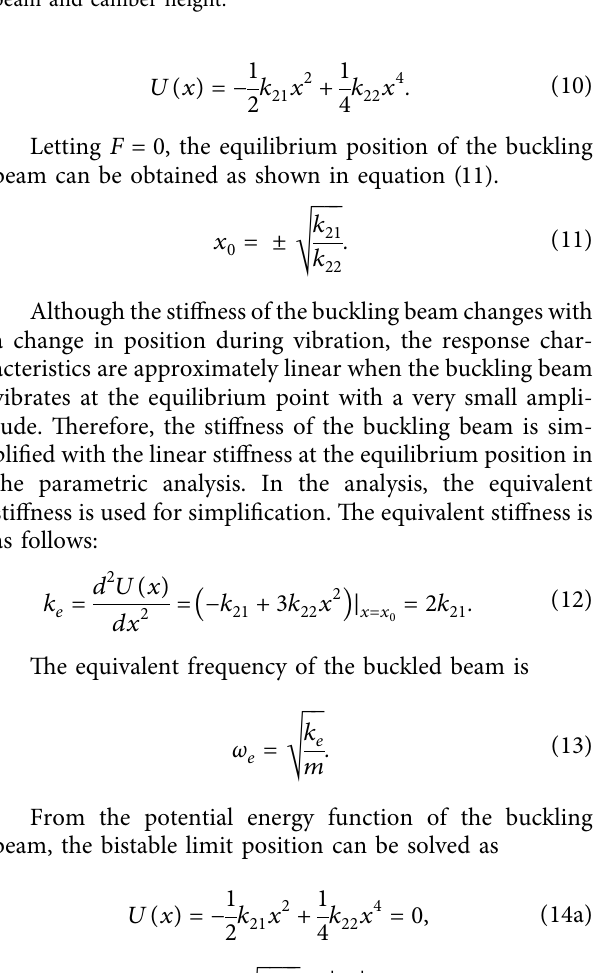
Figure 4: Relationship between equivalent stifness of buckling beam and camber height.